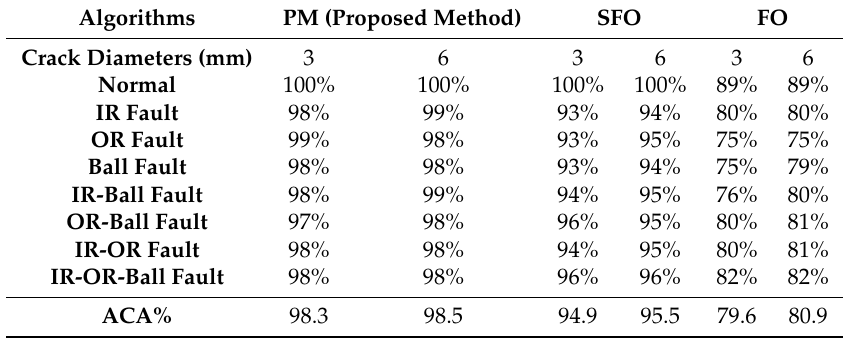
Table 11. The multi-fault diagnosis accuracy for 500 RPM torque